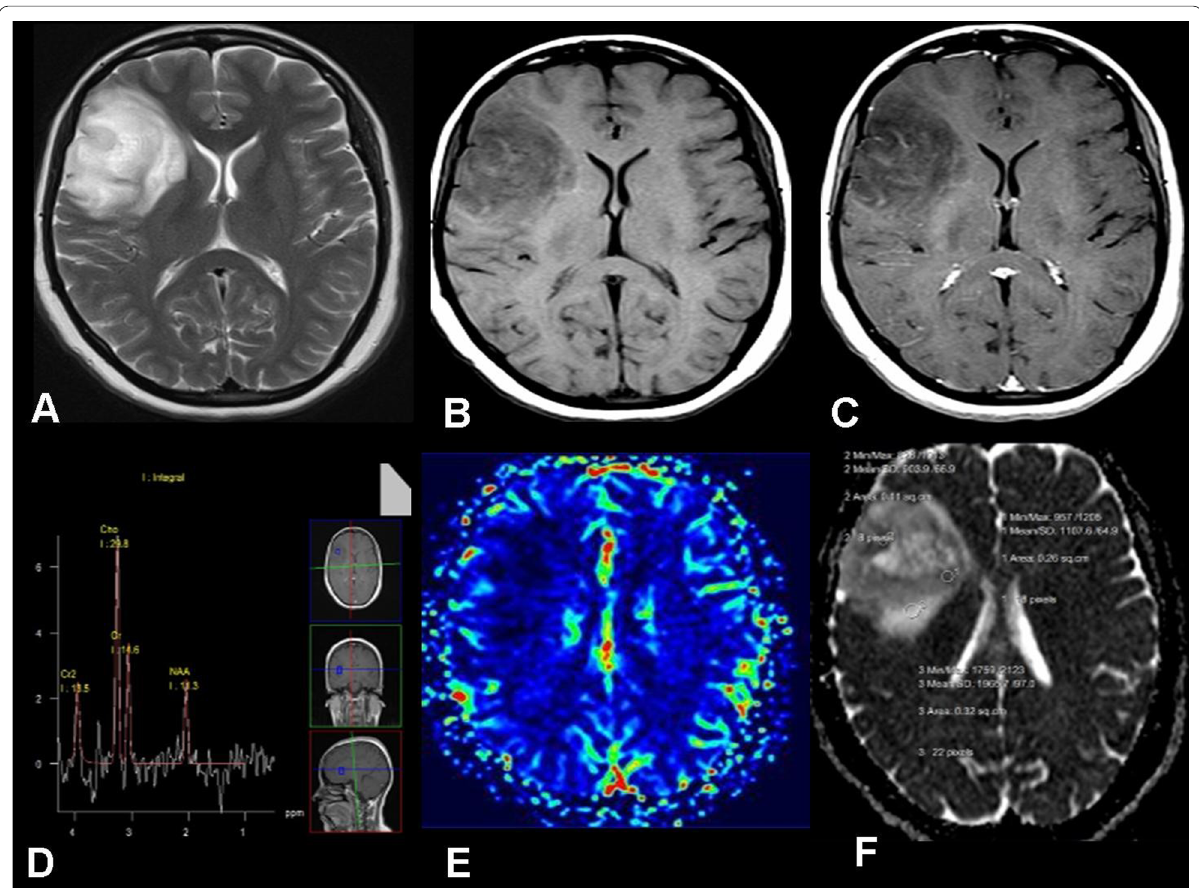
Fig. 2 40-year-old female with left hemiparesis showing right fronto-parietal cortical and sub cortical lesion A , B , C axial T2, T1, T1 post contrast. The lesion showed T2 hyper intense, T1 hypo intense signals with no enhancement after contrast administration, D intermediate echo spectroscopy curve shows relatively high Cho levels and low Cr and NAA levels. E rCBV color perfusion map for the same lesion shows area of relative hyper-perfusion rCBV 1.6. F ADC image shows relative diffusion restriction (ADC value measures around 0.9 findings are in favor of low-grade glioma. Histopathological examination confirmed the diagnosis diffuse astrocytoma WHO grade